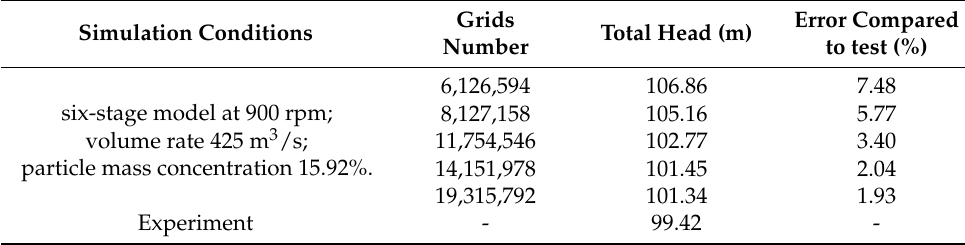
Table 4. Grid-independence simulation